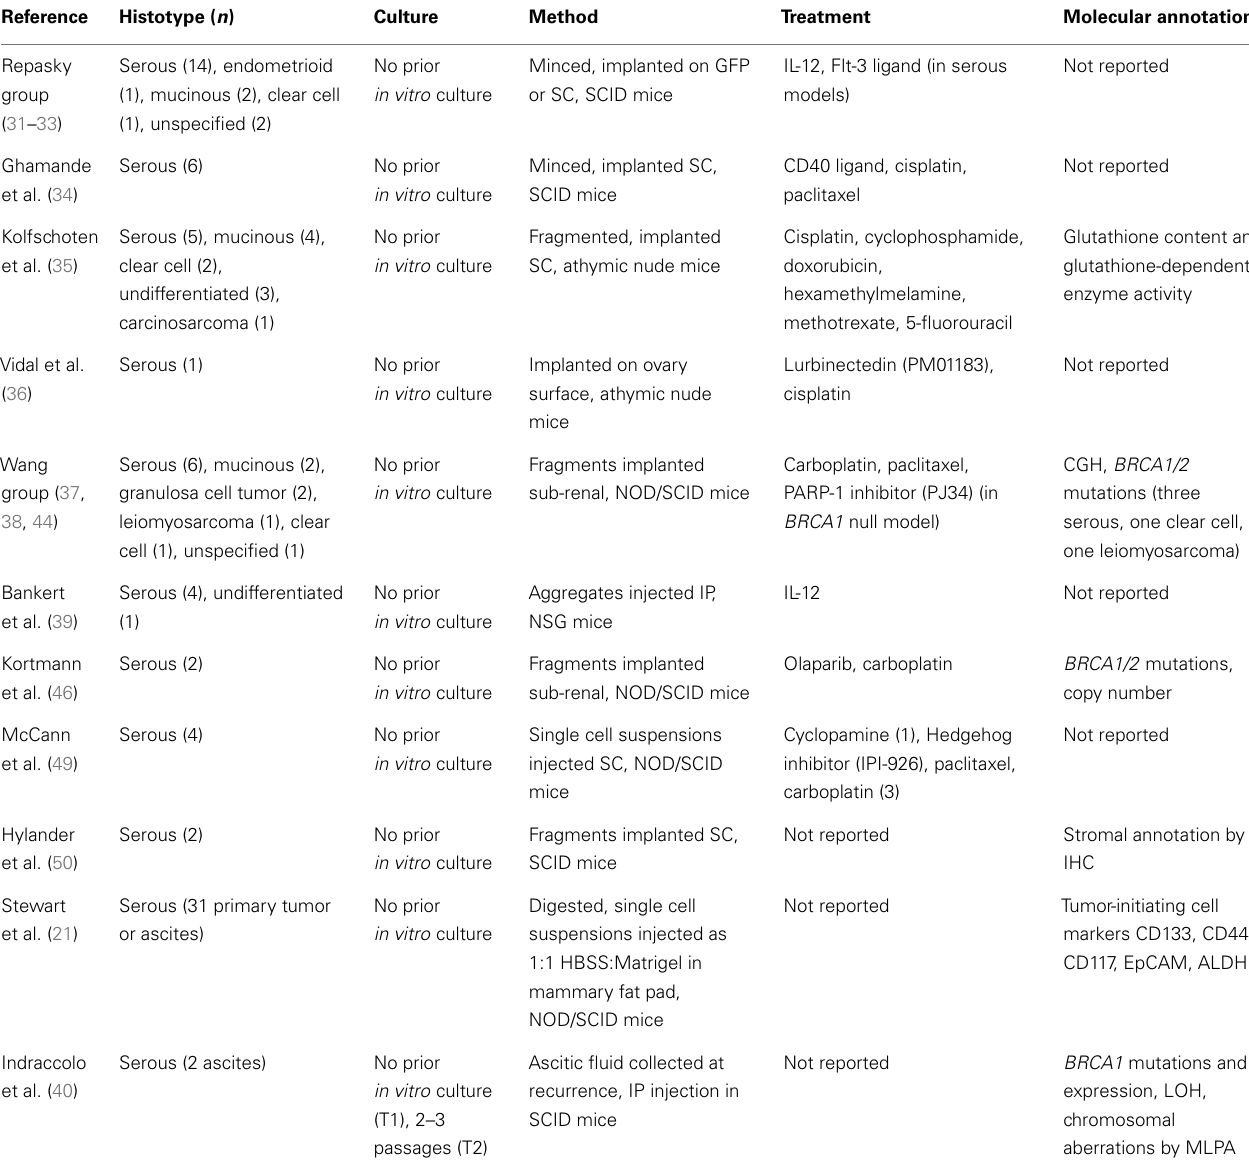
Table 1 | Summary of ovarian cancer PDX models